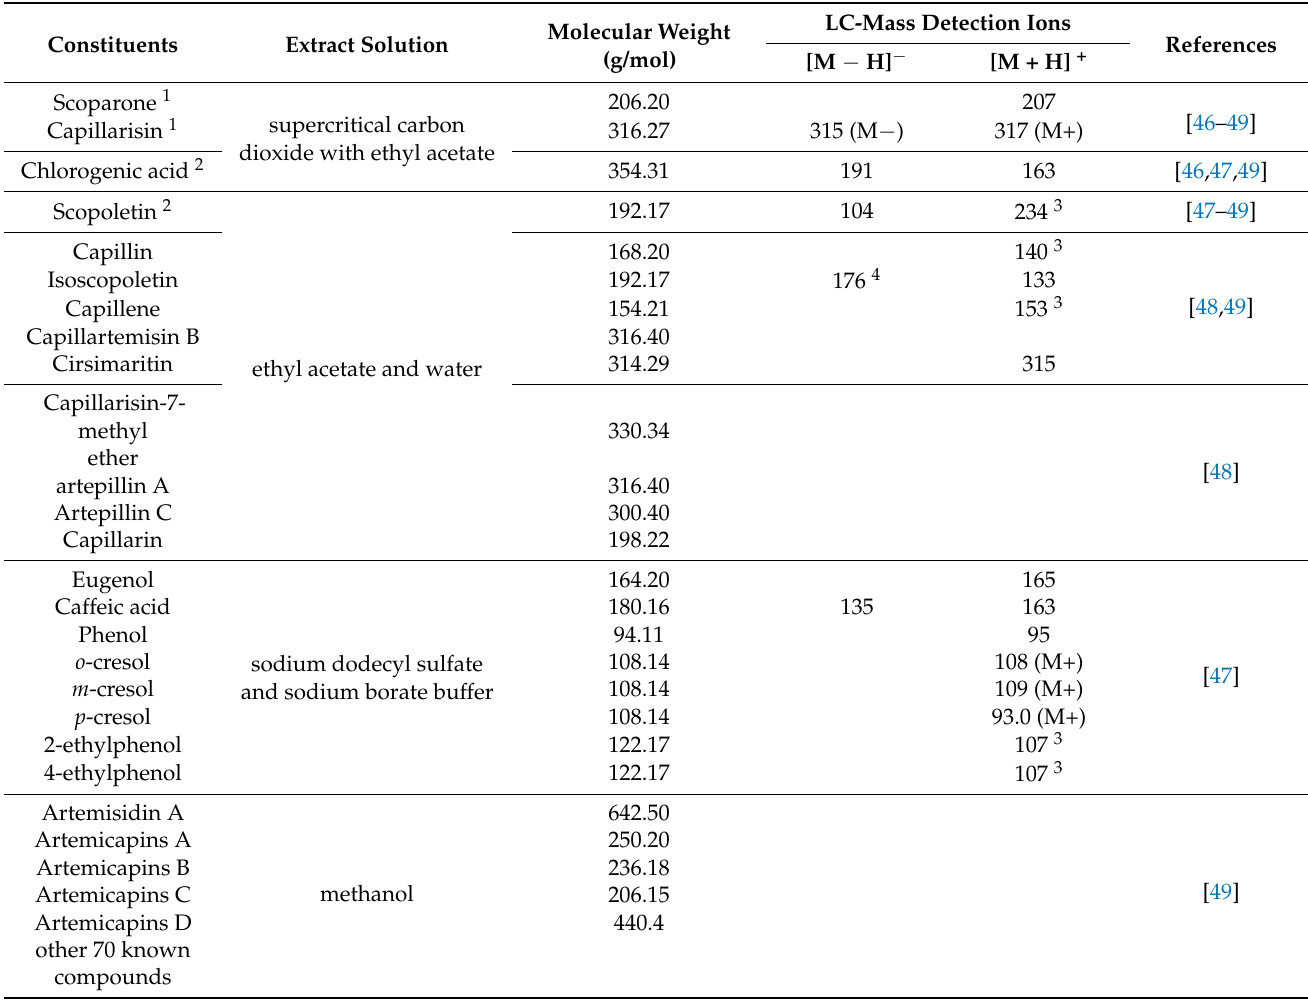
Table 2. Bioactive compounds of Artemisia capillaris extraction